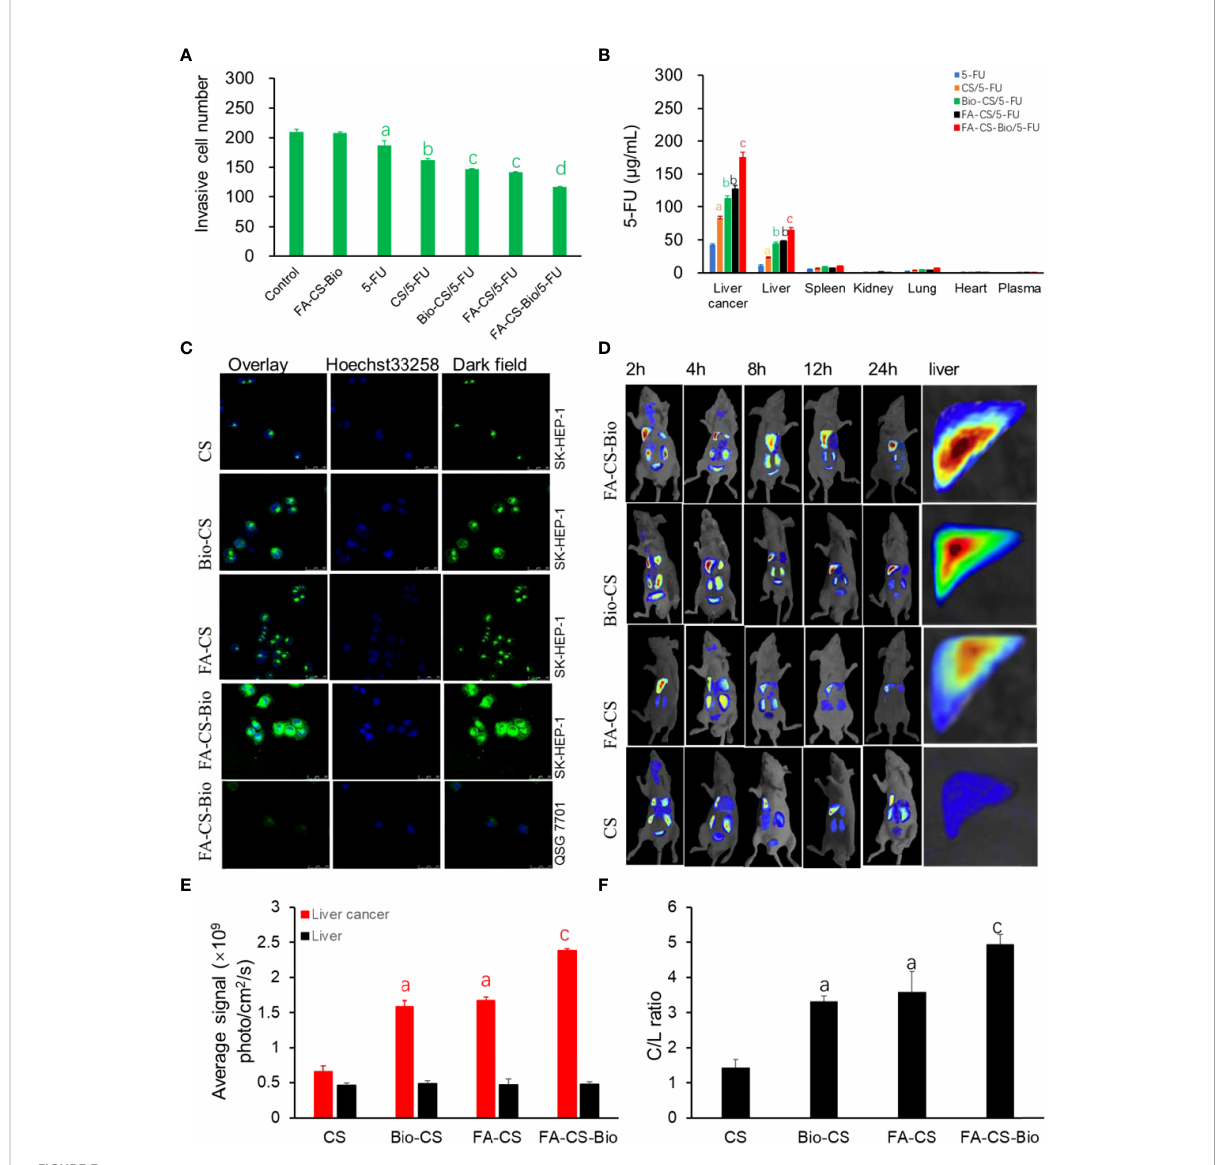
FIGURE 3 Targeting of different 5-FU nanoformulations on hepatoma cells. (A) Effects of different 5-FU nanoformulations on the migration of liver cancer cells. Note: compared with control, a p < 0.01; compared with 5-FU, b p <0.01; compared with CS/5-FU, c p < 0.01; compared with FA-CS/5-FU or Bio-CS/5-FU, d p < 0.01. (B) Effects of different 5-FU nano-formulations on the concentration of 5-FU in different tissues of mouse orthotopic liver cancer transplantation model. Note: compared with 5-FU, a p < 0.01; compared with CS/5-FU, b p <0.01; compared with FA-CS/5-FU or Bio-CS/5- FU, c p < 0.01. (C) Confocal detection of endocytosis of liver cancer cells by different nanomaterials. (D) In vivo imaging of different nanomaterials in a mouse orthotopic liver cancer model. (E) Fluorescence photon numbers of different nanomaterials in liver cancer and liver tissue. Note: compared with CS, a p < 0.01; compared with FA-CS or Bio-C, c p < 0.01. (F) Comparison of C/L ratios of different nanomaterials. Note: compared with CS, ap<0.01; compared with FA-CS or Bio-C, c p <